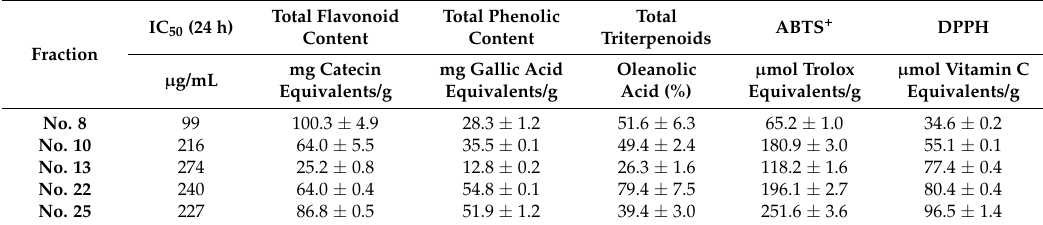
Table 1. The characteristics of AVL ethanolic fractions on antioxidative activity, and the total content of flavonoids, polyphenols, and triterpenoids.